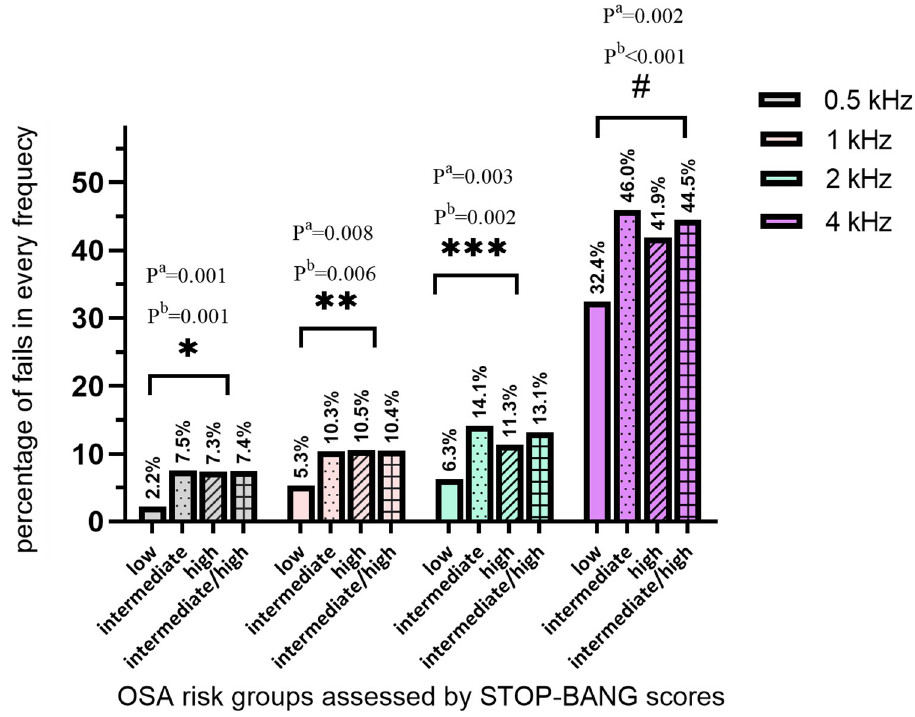
Fig 2. Percentage of pure-tone fails in all screening frequencies grouped by OSA risk based on STOP-BANG scores. P value a : comparing low vs intermediate and high. P value b : comparing low vs intermediate/high. � , �� , ��� , # : P < 0.05, by Pearson χ 2 test. Plain columns: low OSA risk, columns with dots: intermediate OSA risk, columns with stripes: high OSA risk, columns with squares: intermediate/ high OSA risk.